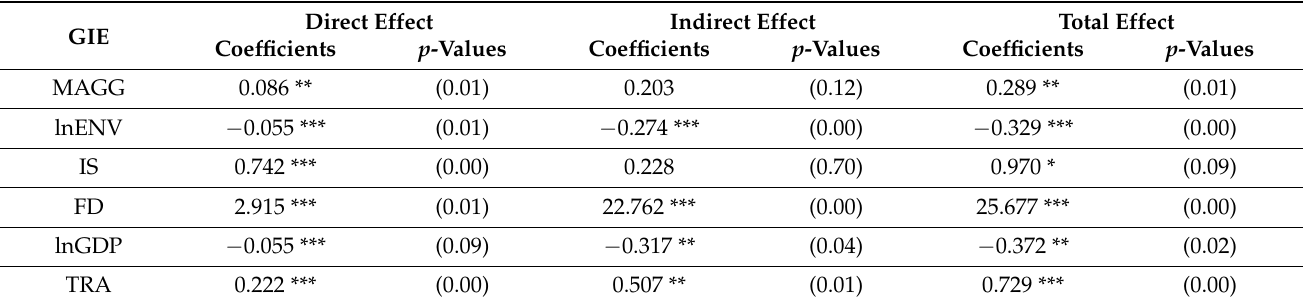
Table 9. The results of spatial effect decomposition based on the SDM